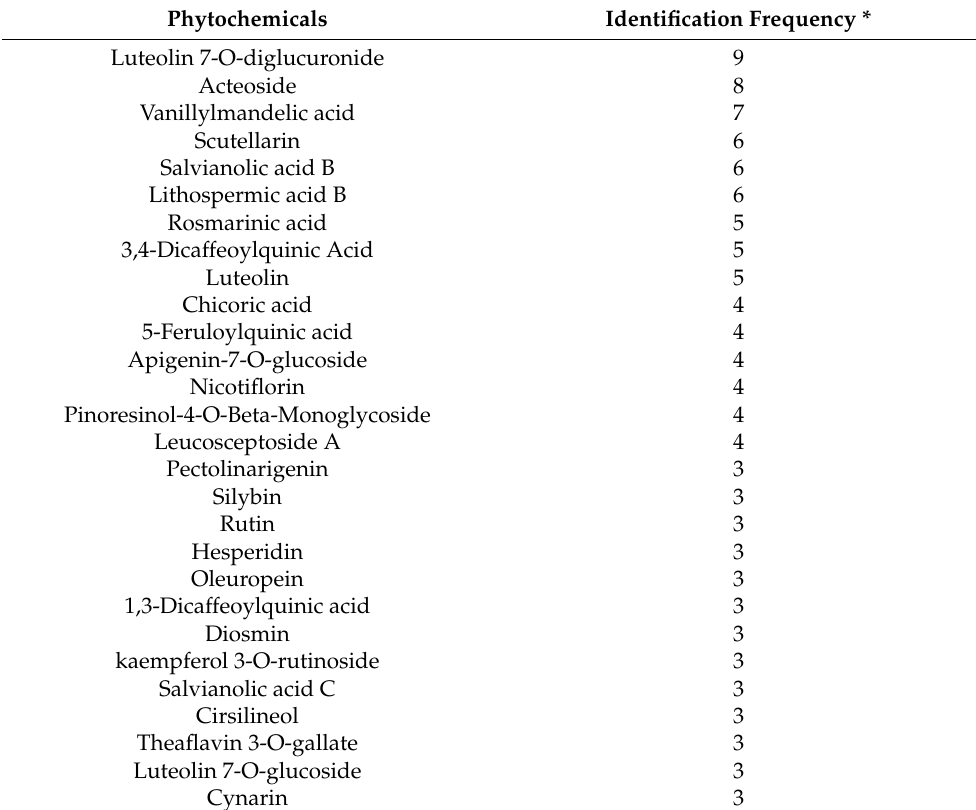
Table 4. Most common antioxidants identified in Lamicaea family of studied plant